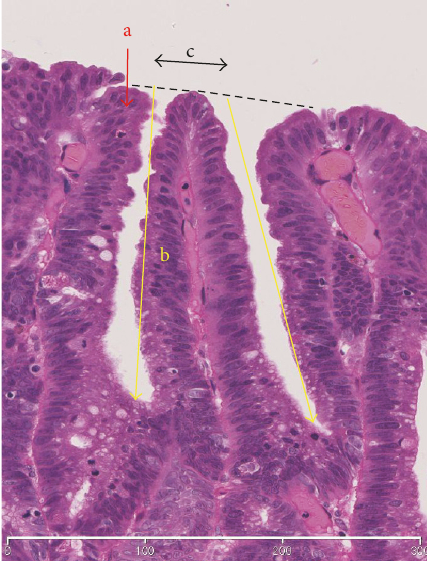
Figure 1: Schema of crypt and epithelium. a, surface epithelium. b, depth of crypt. c, intervening part. Depth of crypt: de fi ned as the distance between the bottom of the crypt and the dotted line that connects the top of the crypt